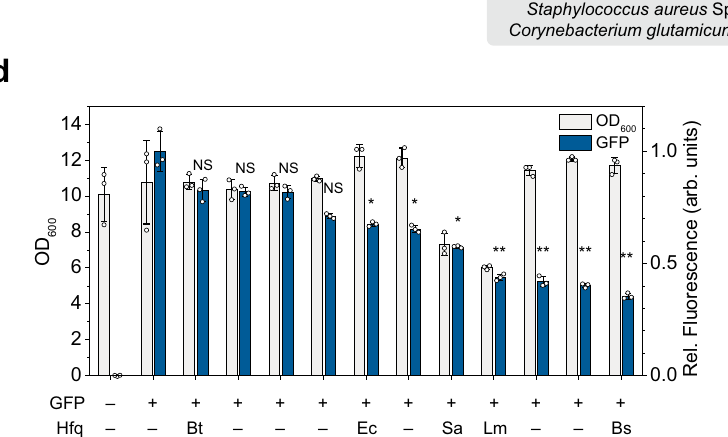
Abbreviations for Hfq: Bs, B. subtilis Hfq; Ec, E. coli Hfq; Lm, L. monocytogenes Hfq; Sa, S.aureus Hfq.AbbreviationsforsRNAscaffolds:Arn,ArnA;Bts,BtsR1;Lhr,LhrA; Mic, MicC; Sco, Scr5239; Spr, SprX1; Rox, RoxS. * P <0.0045, ** P <0.00091, deter- mined by two-tailed Student ’ s t -test. P -value thresholds were adjusted using